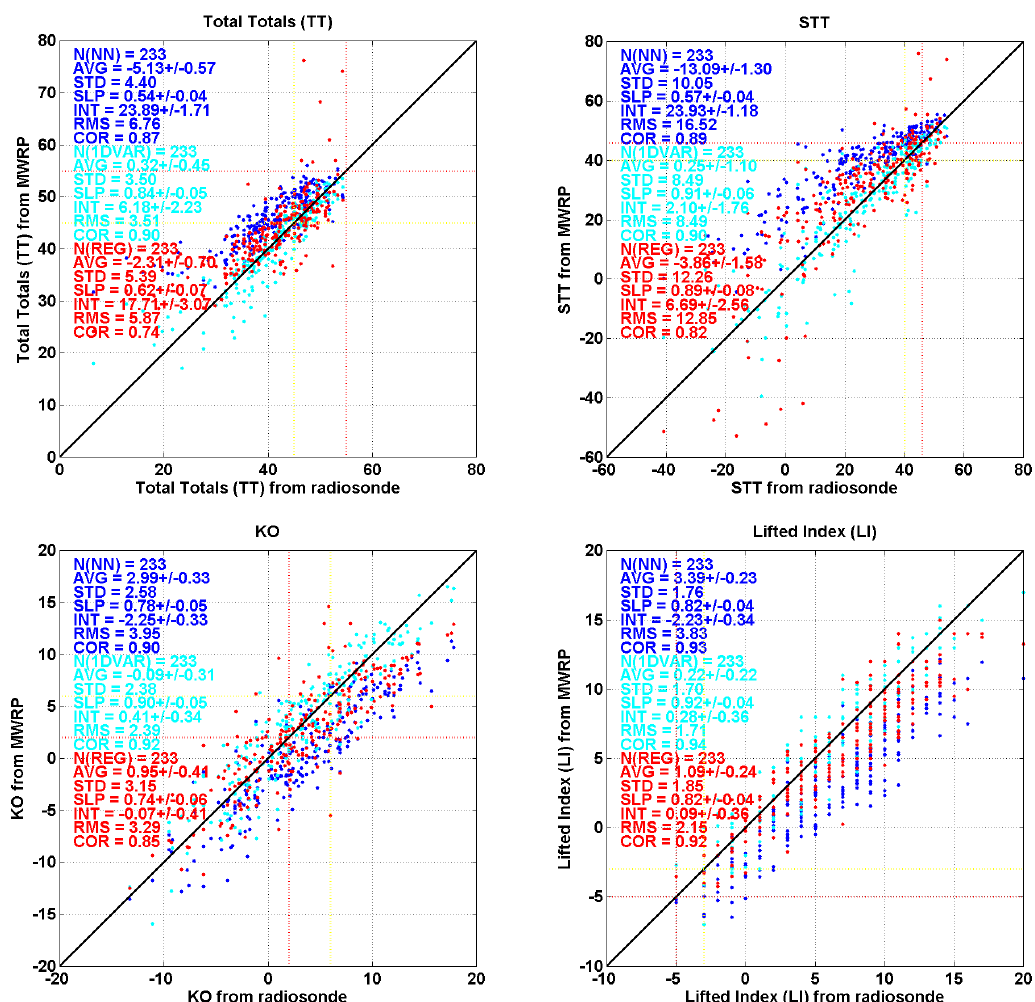
Figure 11. As in Fig. 9 but for (clockwise from top-left panel) total totals, STT, KO, lifted index. Dotted yellow and red lines indicate thresholds for moderate and high potential, respectively (where